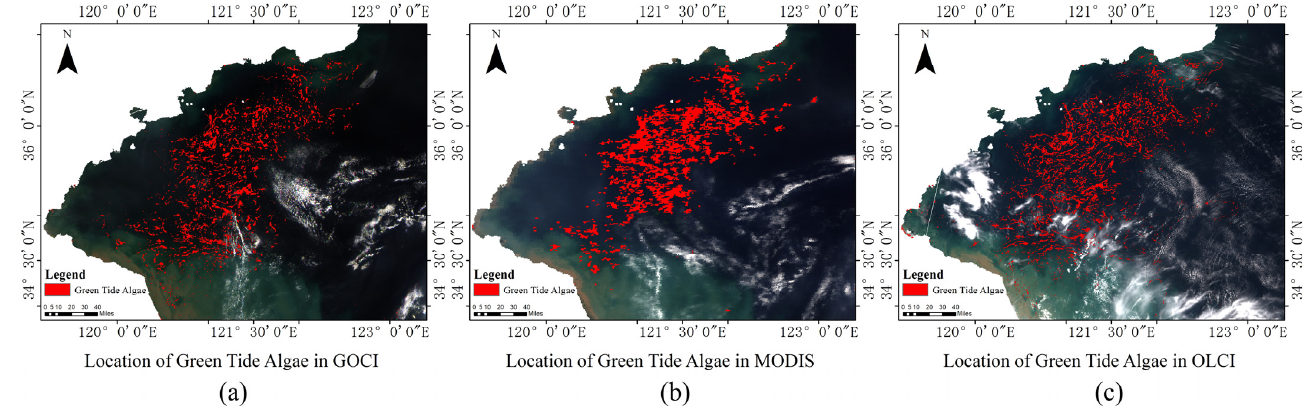
Figure 3. Extraction results and spatial location determination of green tide algae: ( a ) GOCI, ( b ) MODIS and ( c ) OLCI.